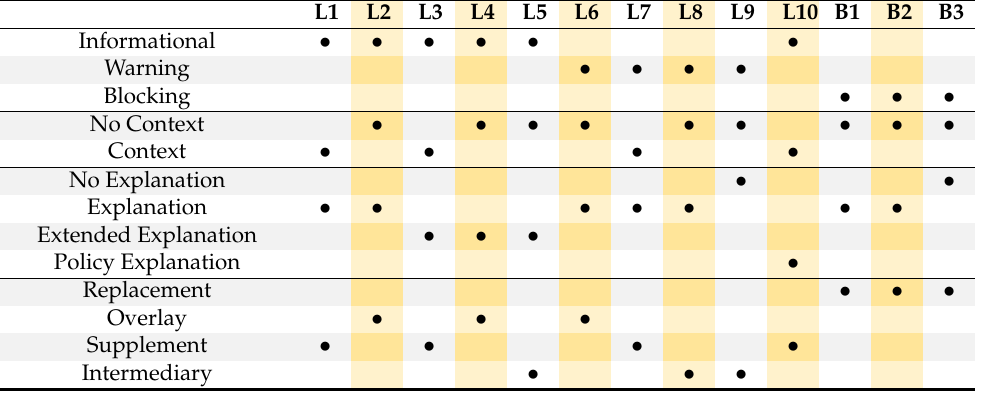
Table 7. Categorizations of